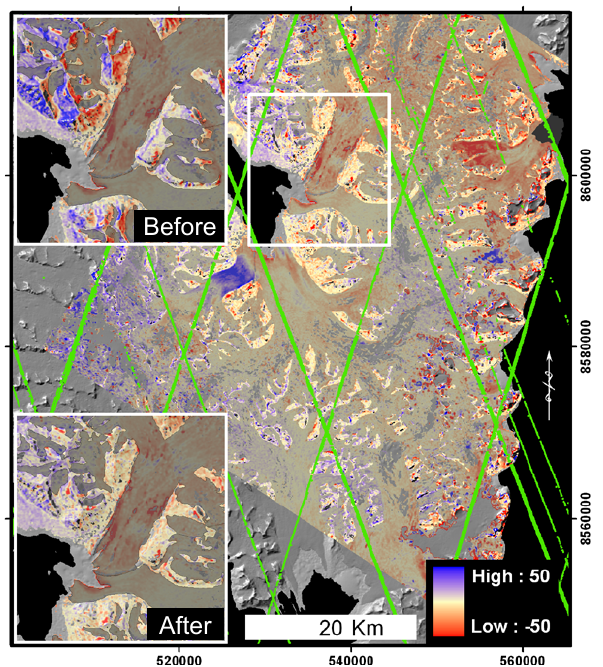
Fig. 8. Elevation differences before and after co-registration of the ASTER DEM to the SPOT5-HRS DEM. The final shift is ≈ 2.5 ASTER pixels to the west-north-west. The green lines are the ICE- Sat tracks. The glacier area is shaded with a transparent gray to emphasize the stable terrain differences.